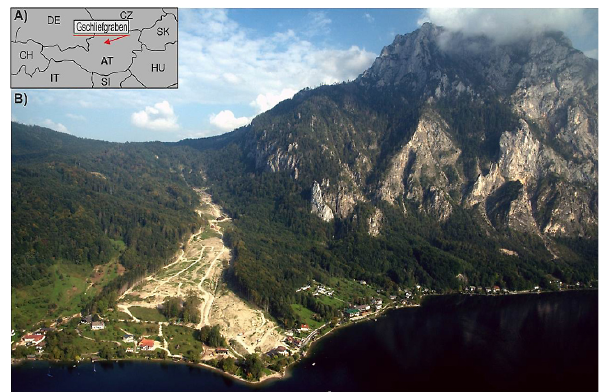
Fig. 1. General setting of the Gschliefgraben site: (A) Position within Austria, (B) Airborne photo of the Gschliefgraben valley and Mt. Traunstein from the west (Photo by: R. Supper,